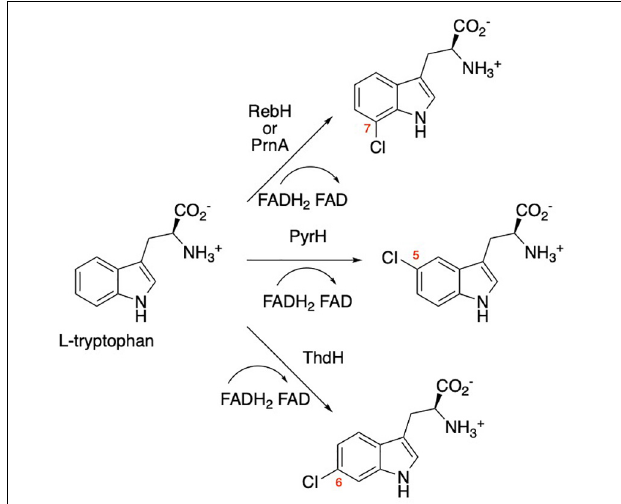
FIGURE 1 | Regioselective halogenation of tryptophan by flavin-dependent bacterial halogenases RebH, PyrnA, PyrH, and ThdH. RebF is a flavin reductase (not shown) that recycles the flavin